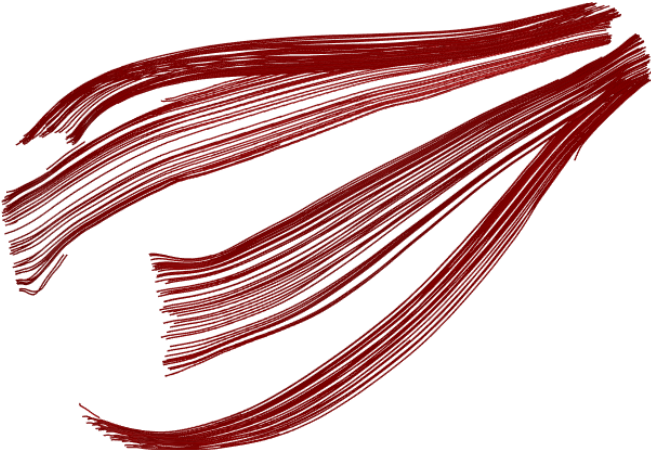
Figure 3. Representation of the muscle and collagen fiber